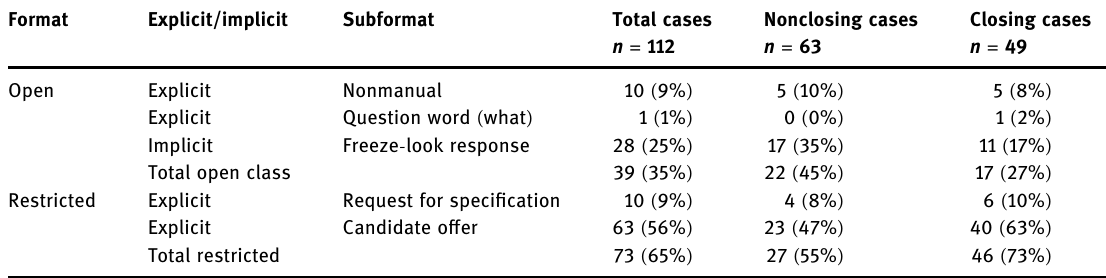
Table 3: Distribution of di ff erent formats for repair initiation in the total NTS data and in nonclosing and closing cases